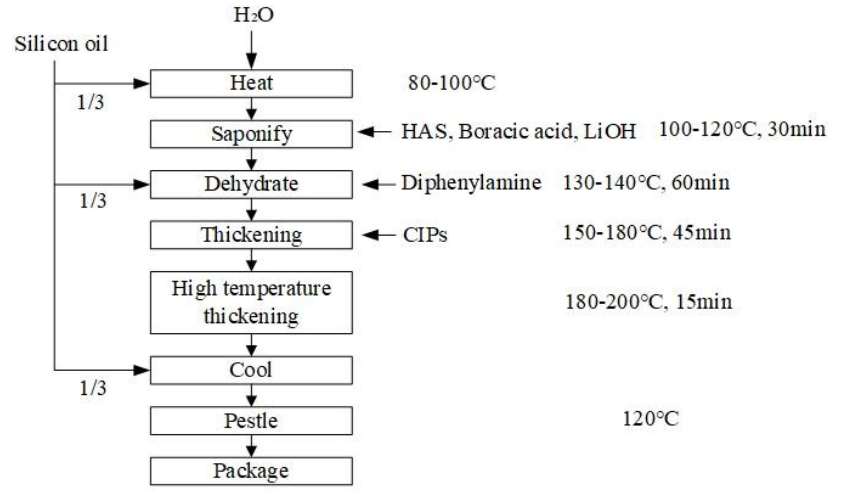
Figure 1. The preparation process of composite lithium-based MR grease.